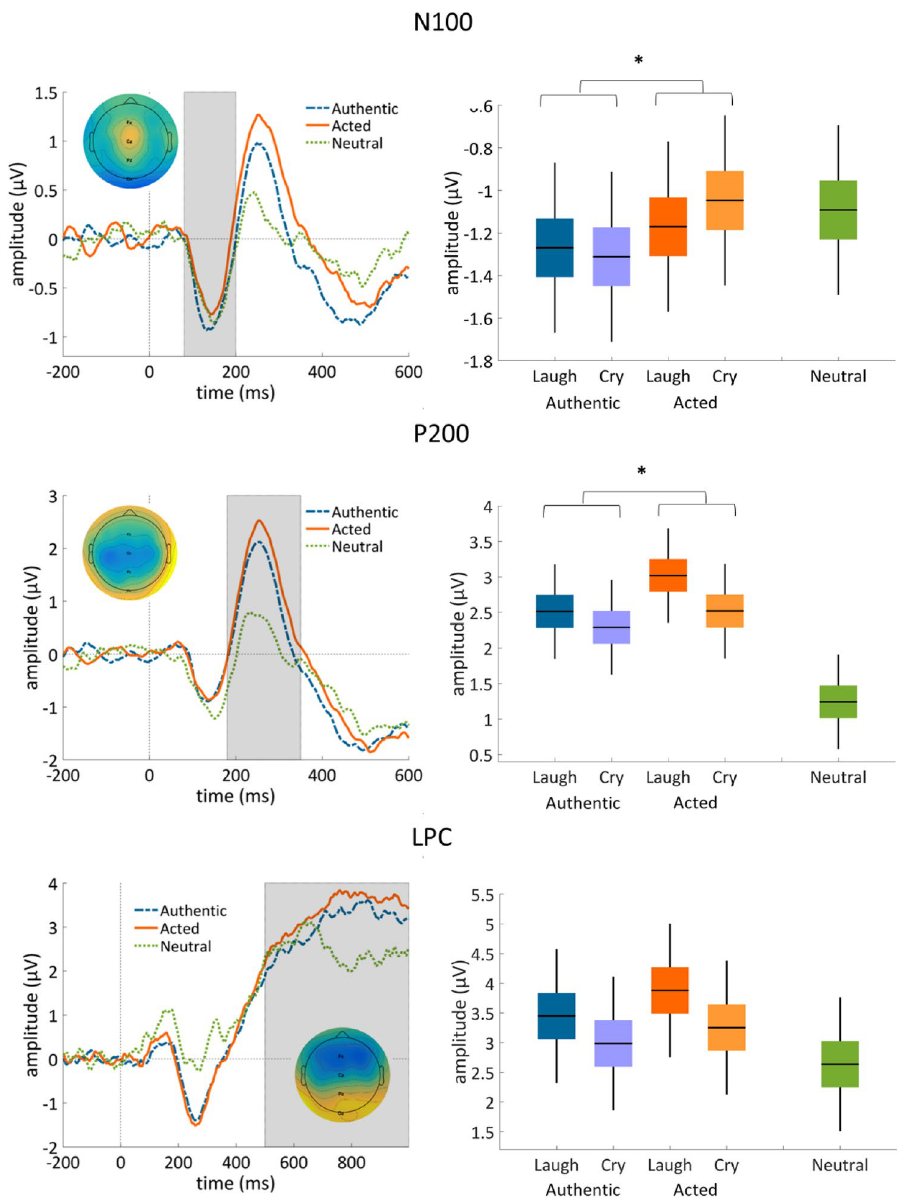
top), P200 (180–350 ms; middle), and LPC (500–1000 ms; bottom), collapsed across laughter and crying. Topographical maps represent the components averaged across the 4 conditions (authentic/acted laughter and crying), within the time windows of interest. Grey-shaded areas represent the analysis time window. Right panel shows box plots of the measured ERP amplitudes. For each box plot, black horizontal line represents the mean, black vertical line is one standard deviation, and coloured patches represent 95% within-subject confidence intervals. Statistically significant effects (Bonferroni-corrected p < 0.05) of authenticity are signalled with an